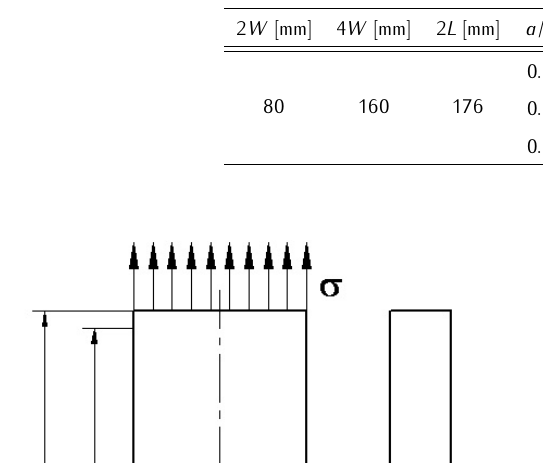
Table 1. The geometrical dimension of the CC(T) specimen used in numerical analysis